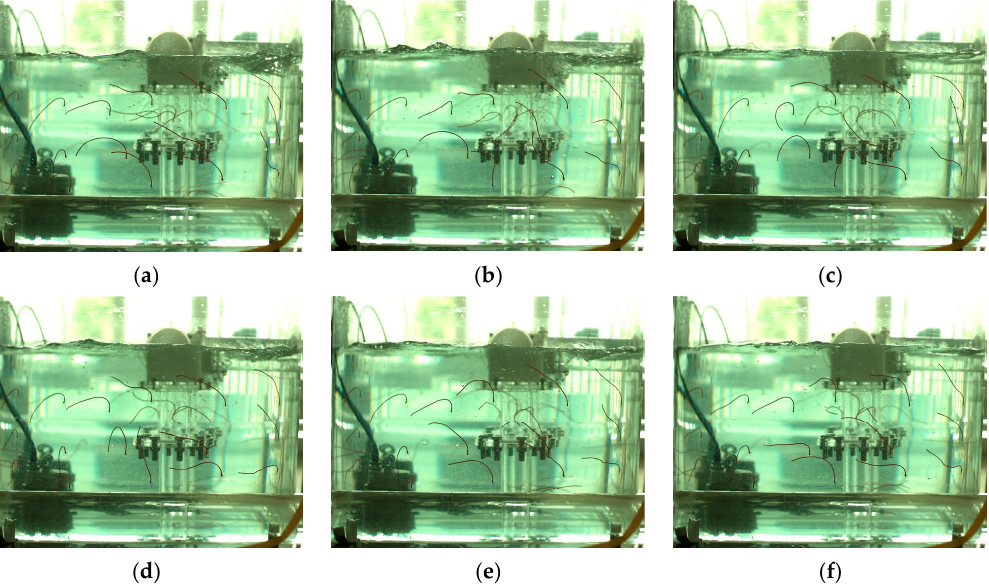
Figure 13. Experimental flow pattern before optimization. ( a ) 0.005 s. ( b ) 0.645 s. ( c ) 1.285 s. ( d ) 1.925 s. ( e ) 2.565 s. ( f ) 3.205 s.